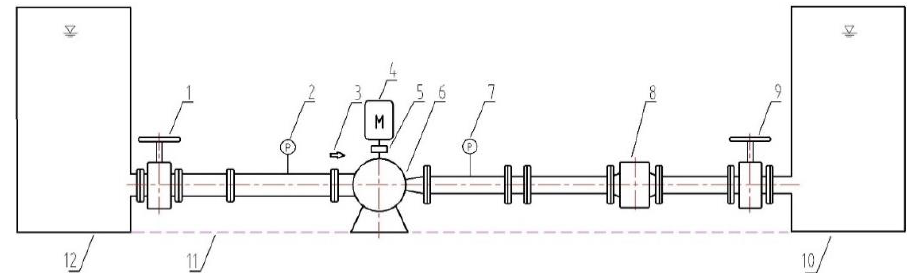
Figure 9. Hydraulic performance test rig: 1—Inlet valve; 2—Inlet pressure gauge; 3—Laser tachometer; 4—Electromotor; 5—Torque transducer; 6—Centrifugal pump; 7—Outlet pressure gauge; 8—Electromagnetic flowmeter; 9—Outlet valve; 10—Water drainage tank; 11—Base line; 12—Water supply tank.